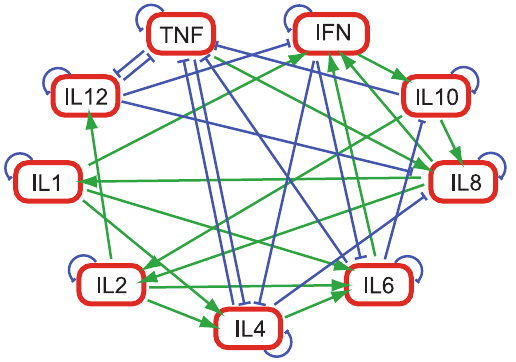
Figure 4. Most significant inductive and inhibitive accelera- tions in the cytokine coupling matrix. Arrowhead denotes induction; ‘‘T’’ represents inhibition.